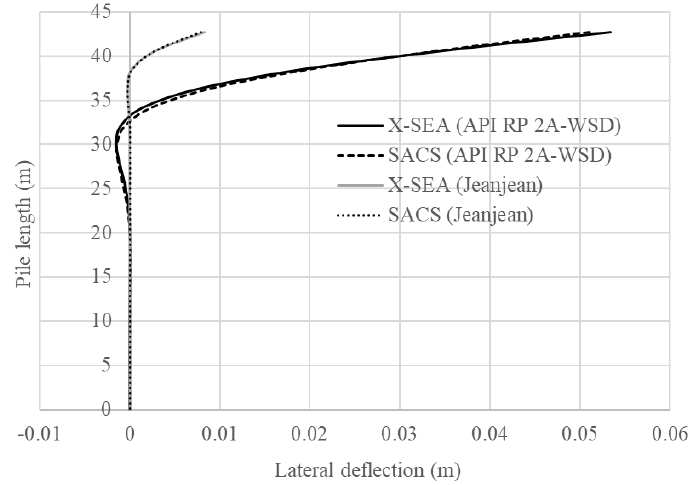
Figure 9. Lateral deflection along the pile length.